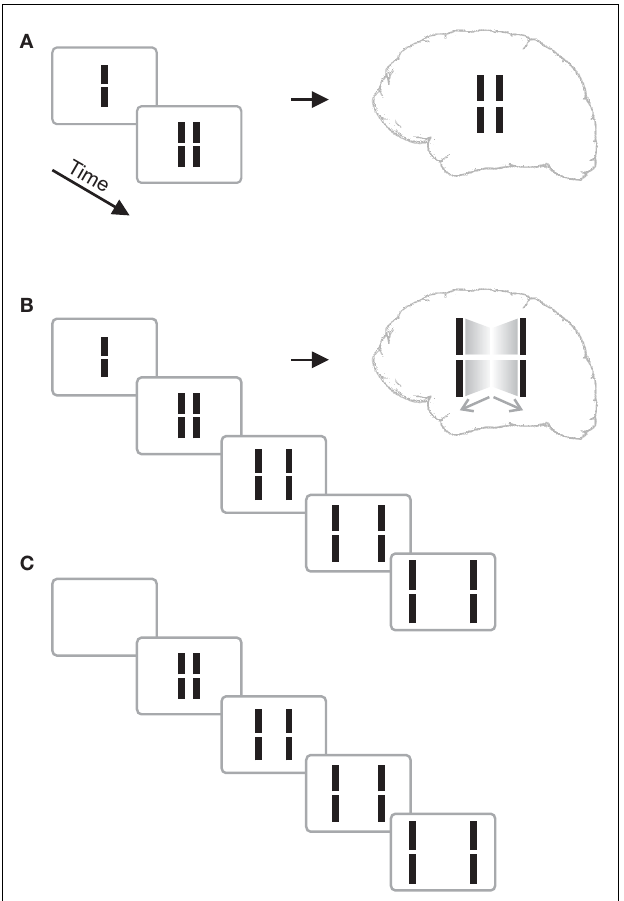
FIGURE 1 | (A) Classical metacontrast. A central vernier (i.e., a vertical line with a small gap in the middle) is followed by two, non-overlapping verniers. The central vernier is rendered largely invisible if the flanks appear 50ms later. (B) Sequential metacontrast.The central vernier is followed by four successive pairs of flanking verniers. A percept of two motion streams to the left and right is elicited with the central line being invisible. (C) Sequence as in (B) without the central vernier. Copyright ©2006 ARVO. Reproduced from Otto et al.